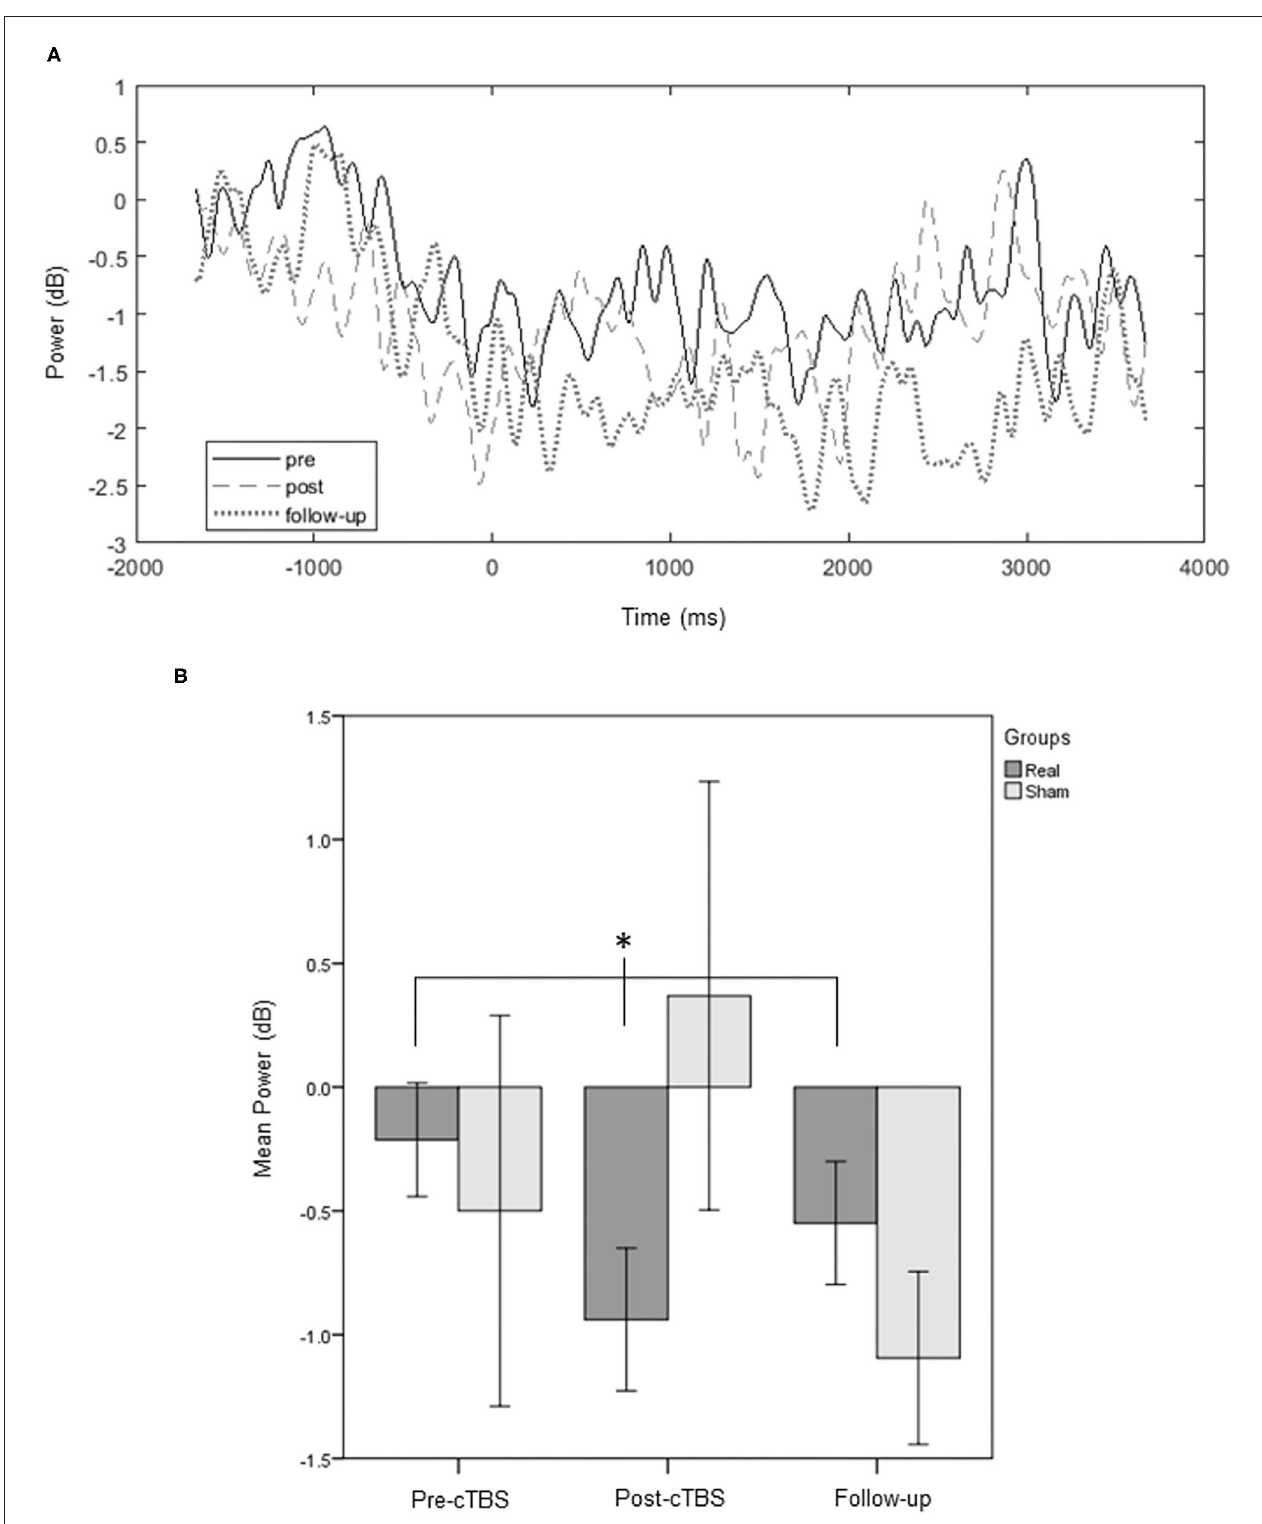
FIGURE 5 | Time-response plots of the mean beta power. A group average response of the ipsilesional motor area for an average of the channels of interest (FC3 or 4; FC1 or 2; C3 or 4; C1 or 2; Cz; CP3 or 4; CP1 or 2) is represented, for the experimental group, throughout the three assessment points. Pre-movement and preparation of the affected thumb opposition reveal changes induced by the protocol on beta power of the affected hemisphere (A) . Significant differences (* p < 0.05) are also illustrated in the bars chart (B) . Error bars represent ± 1 SE.